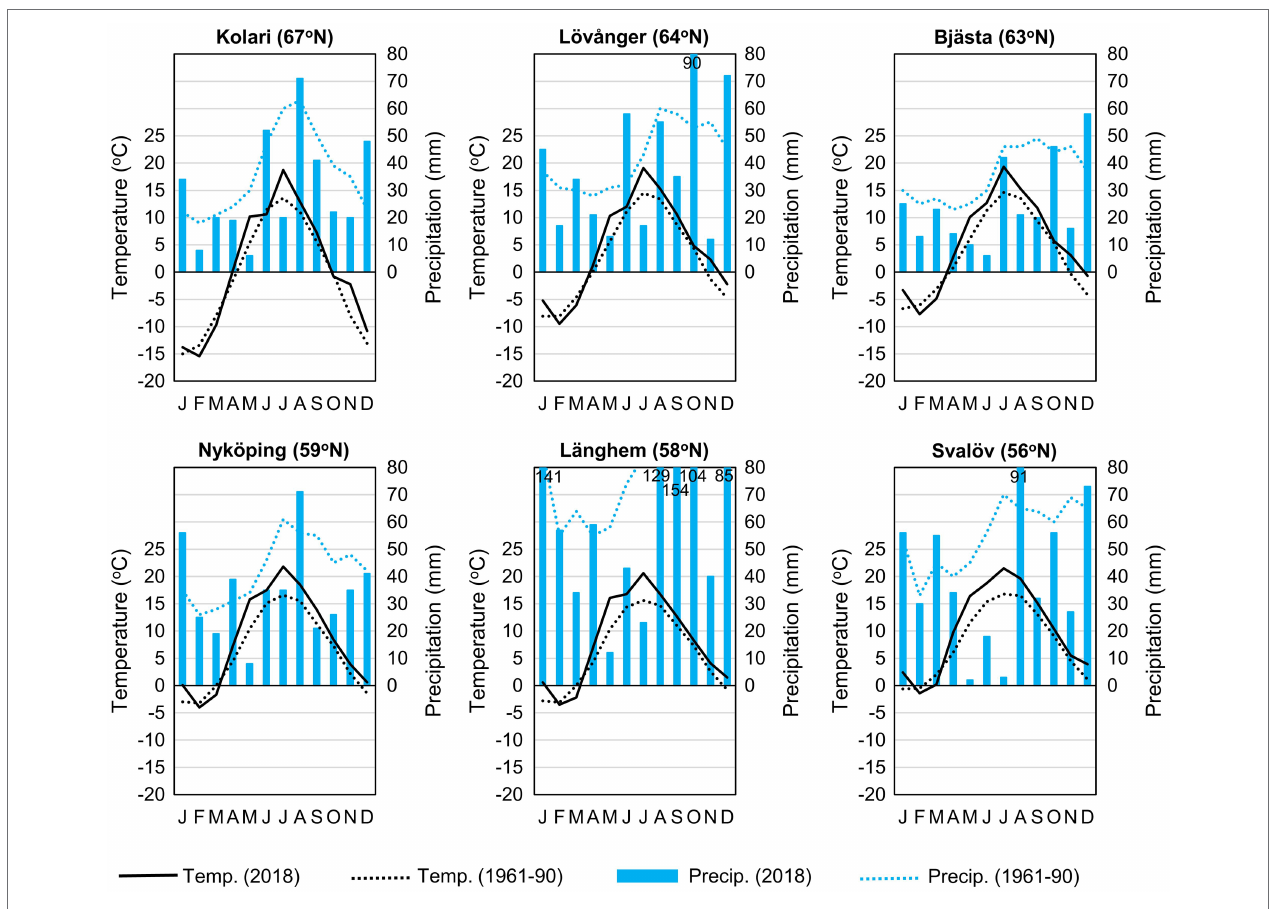
FIGURE 2 | Climate diagrams of the study sites (in sampling year 2018 and long term; SMHI,